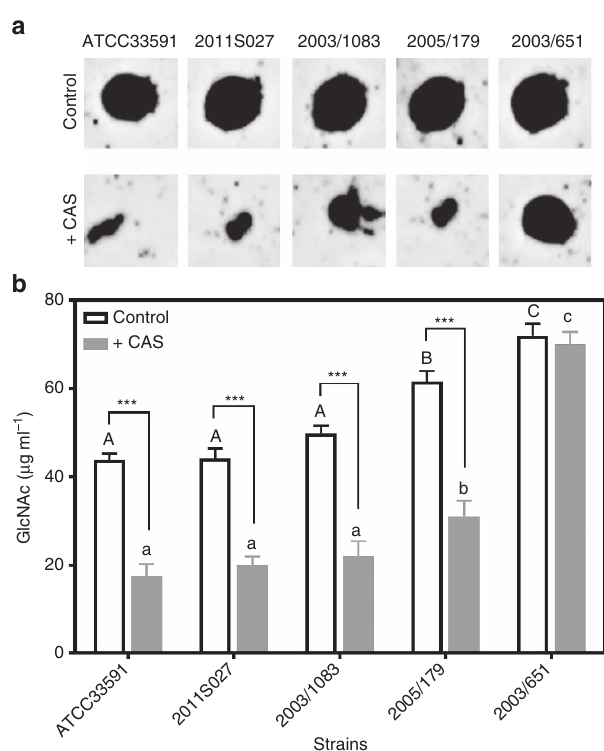
Figure 8 | Effect of caspofungin on poly- b (1-6)- N -acetylglucosamine in biofilms. Biofilms were incubated during 24h in the absence (control) or in the presence ( þ CAS) of 40mgl (cid:2) 1 caspofungin. ( a ) Immunoblot analysis of PNAG purified from biofilms. ( b ) Determination of N -acetyl-glucosamine (GlcNAc) concentration after treatment of purified PNAG during 1h with 0.1% Dispersin B. The released GlcNAc monomers were detected by fluorescence ( l exc 545nm; l em 604nm). All data are mean ± s.d. of triplicates. Statistical analysis (two-way ANOVA; Tukey post-hoc test): groups with different letters (caps: control; small letters: þ CAS) are significantly different from one another ( P o 0.05); *** ( P o 0.001): comparison of control to CAS for each individual